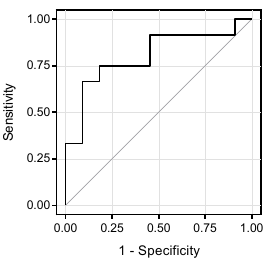
Figure 4. Receiver operating characteristic (ROC) curve of valine for predicting HFF progression in obese youth. The area under the ROC curve was 0.803. With a cutoff of 276 µmol, valine levels had 66.7% sensitivity and 90.9% specificity to predict increases in HFF.